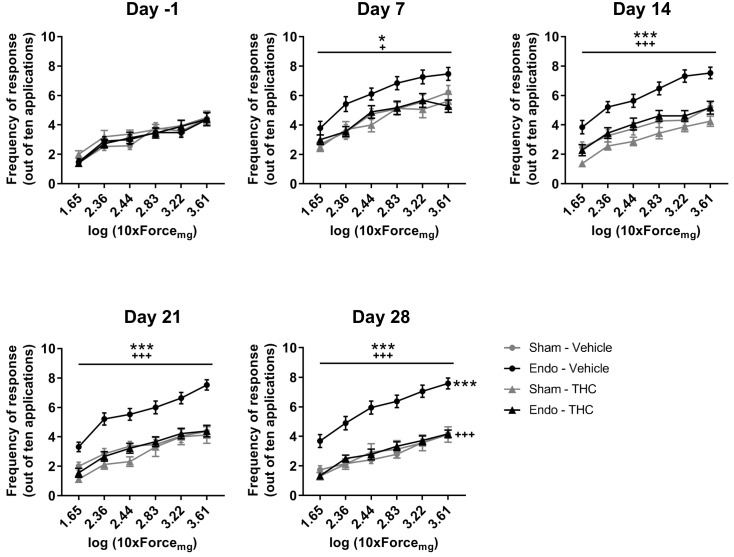
Effect of chronic THC treatment on nociceptive responses to abdominal mechanical stimulation with von Frey filaments.Endometriosis mice treated with vehicle showed higher frequency of response than endometriosis mice treated with THC and sham mice treated with vehicle. THC dose: 2 mg/kg/day. Error bars are mean ± SEM. Two-way repeated measures ANOVA + Bonferroni. *p<0.05, ***p<0.001 vs sham. +p<0.05, +++p<0.001 vs vehicle. Endo, endometriosis; THC, Δ9-tetrahydrocannabinol.